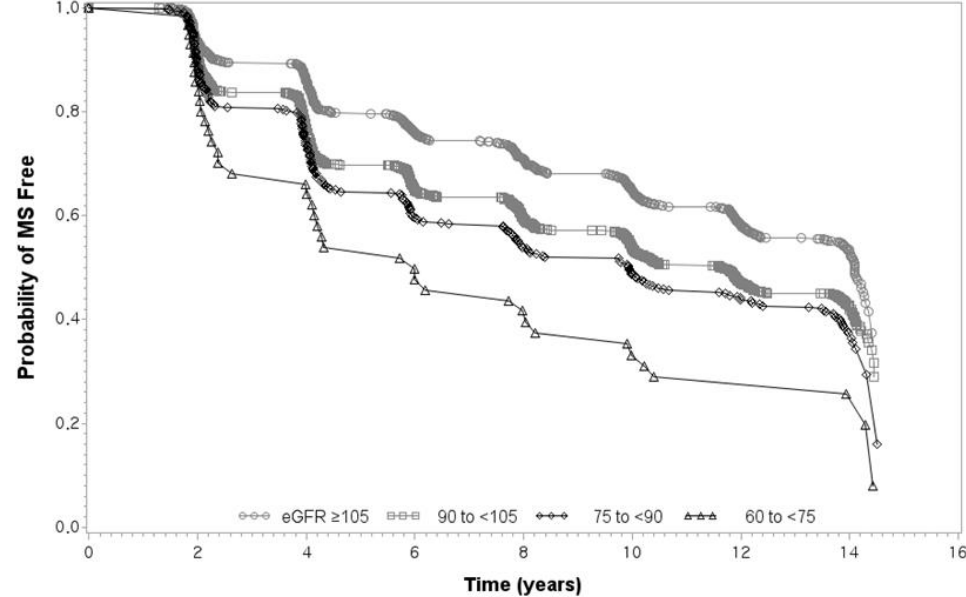
Figure 2. Kaplan–Meier survival curves of incident MS according to eGFR category. Kaplan–Meier survival curves were adjusted for age, sex, education, smoking status, exercise, alcohol consumption, BMI, and menopause for women. MS: metabolic syndrome; eGFR: estimated glomerular filtration rate; BMI: body mass index.